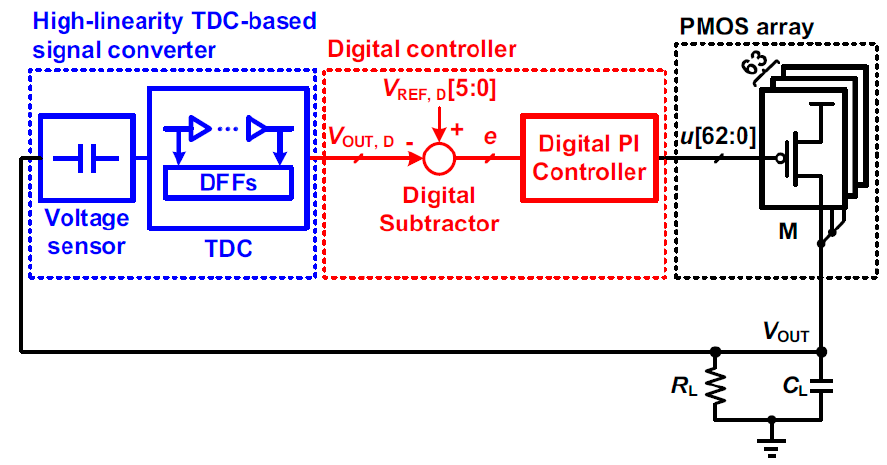
Figure 30. Time-to-Digital Converter (TDC)-based DLDO [57].